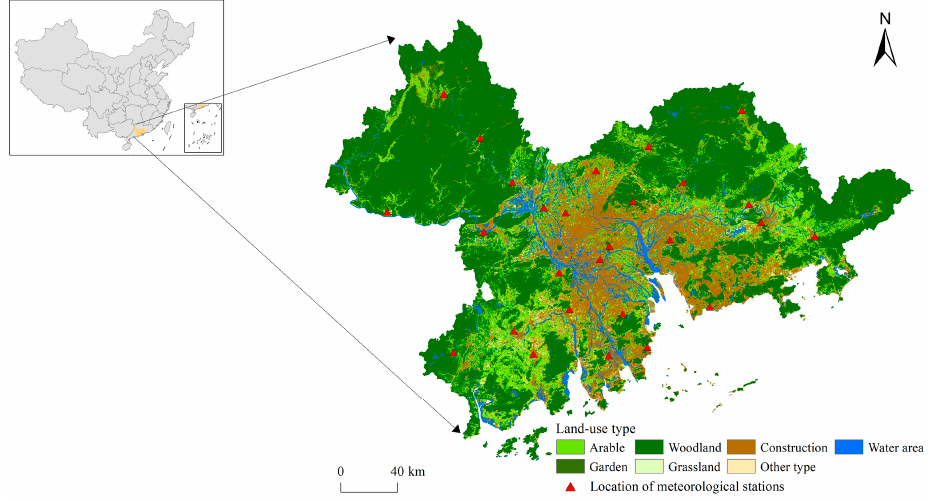
Figure 1. Location and land uses of the study area in